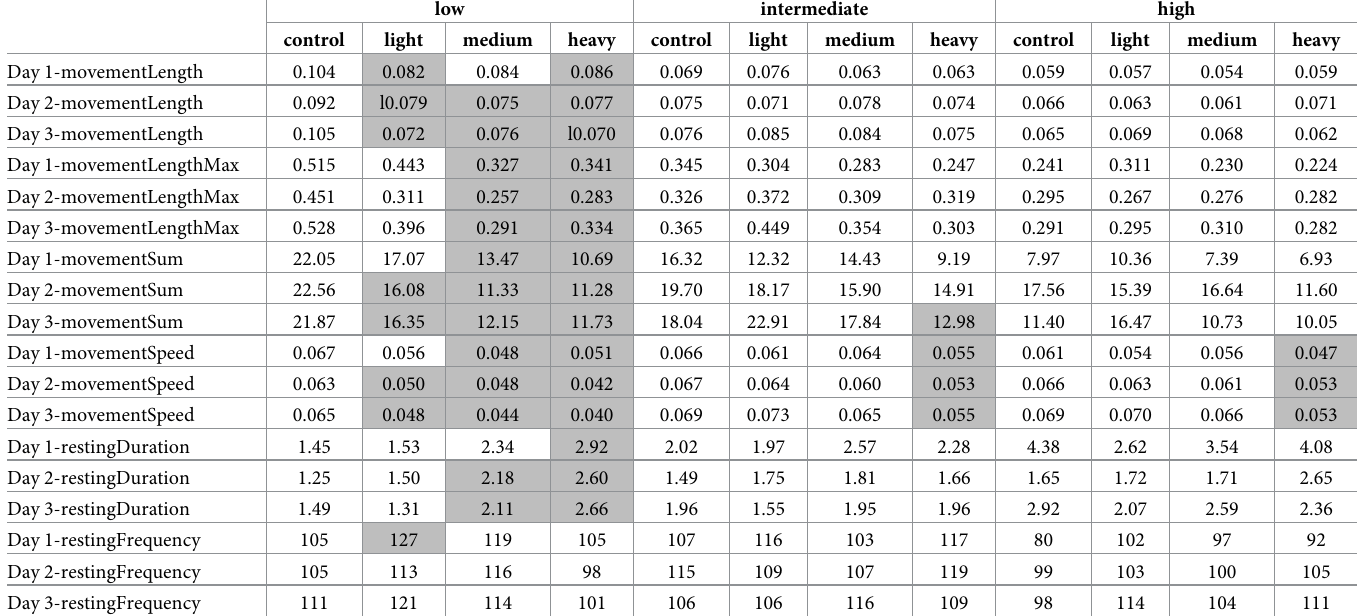
Table 5. Medians of movement properties of control crickets and crickets carrying light, medium, or heavy tags at three temperatures (low, intermediate, or high). Gray highlighted values indicate significant Mann-Whitney tests ( p < 0.05) for comparisons of movement properties of crickets with and without tags at particular